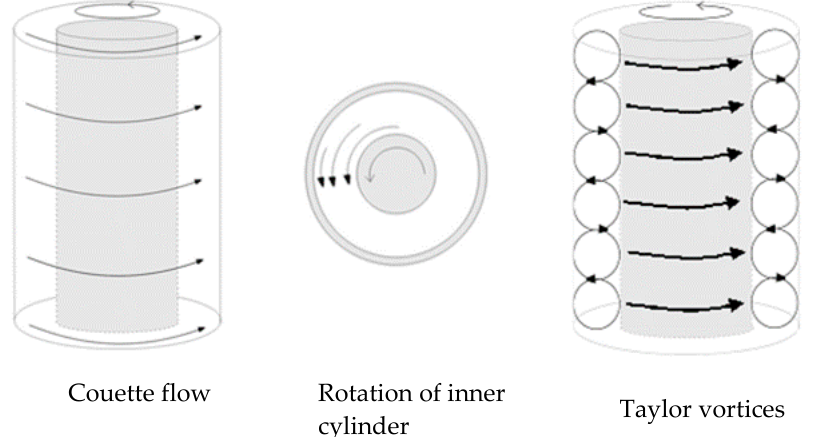
Figure 1. Vortex structures between two concentric cylinders.